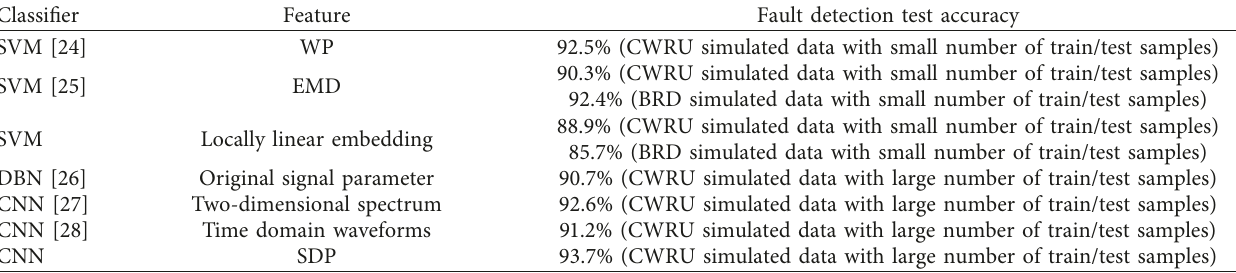
Table 6: Comparison of classification accuracy with different algorithms from the literature.